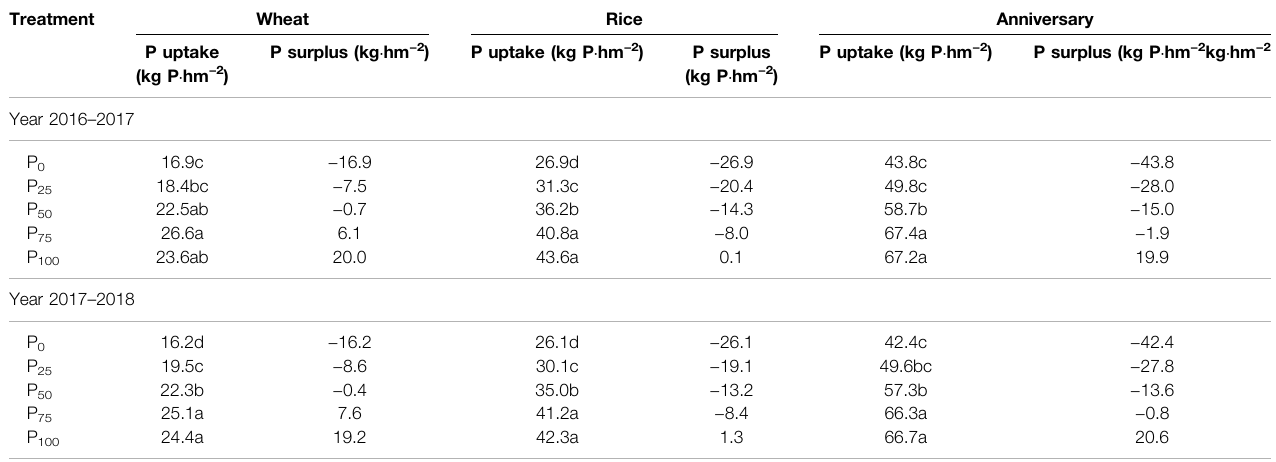
TABLE 4 | Effect of P fertilization rates on P uptake and P surplus. Treatment